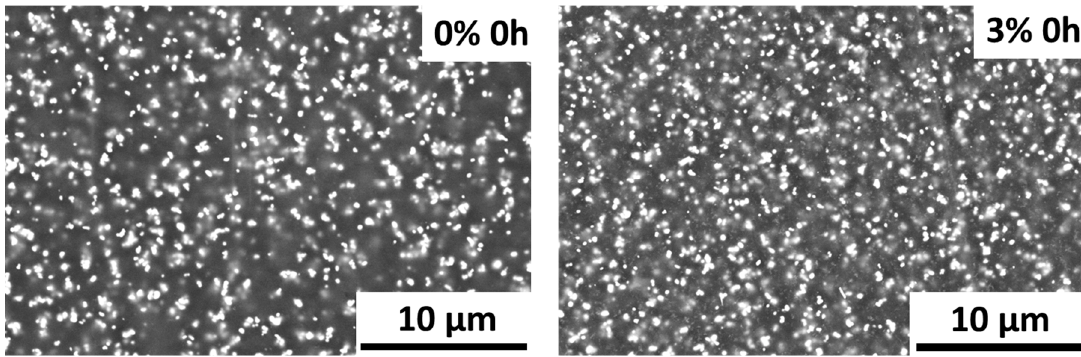
Figure 4. SEM micrographs of the surface 0% and 3% organic coatings before exposure (magnification ×4000).